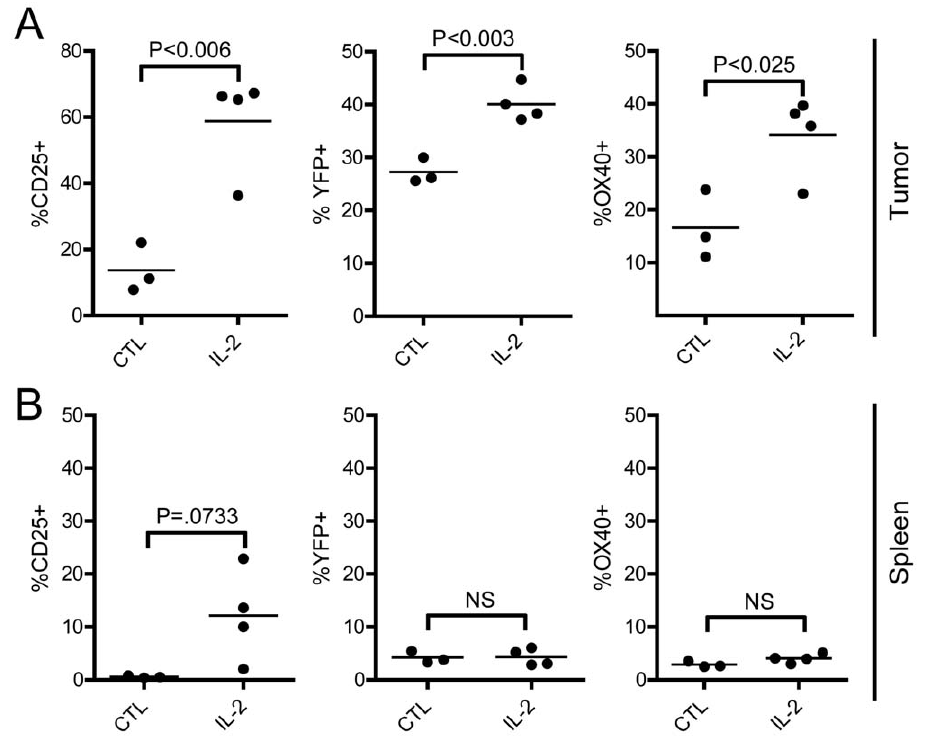
Figure 5. IL-2 treatment enhanced OX40 expression on CD8 T cells in tumor-bearing hosts. A, B ) C57BL/6 OX40-cre x ROSA-YFP reporter mice received 1 6 10 6 MCA-205 sarcoma tumor cells (day 0) and two weeks later, the tumor-bearing mice were treated with IL-2 cytokine/mAb complexes (day 14, 15; i.p.). Twenty four hours later (day 16 post-tumor inoculation) the extent of CD25, YFP (OX40 reporter), and OX40 expression on CD8 T cells isolated from the A ) tumor and B ) spleen were assessed. Graphs depict the results obtained from 3–4 individual animals from 1 out of 2 independent experiments.